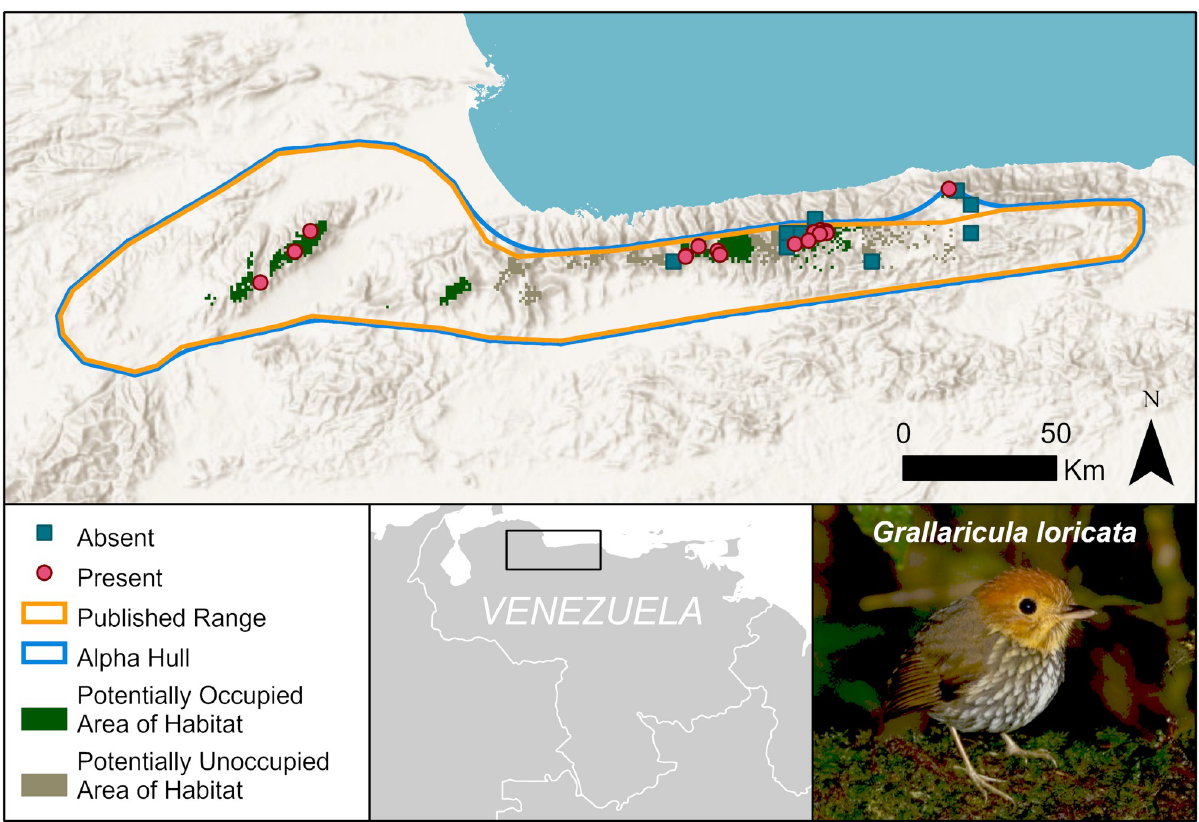
Fig 7. Distribution of the scallop-breasted antpitta, Grallaricula loricata . Due to habitat loss and restricted elevational range, the Area of Habitat is much smaller than the current published range size. Symbology is simplified to show absences (blues squares) as the centroids of absence grid cells. Basemap provided by USGS and photo provided by Margareta Wieser (Macaulay Library, ML205392301).